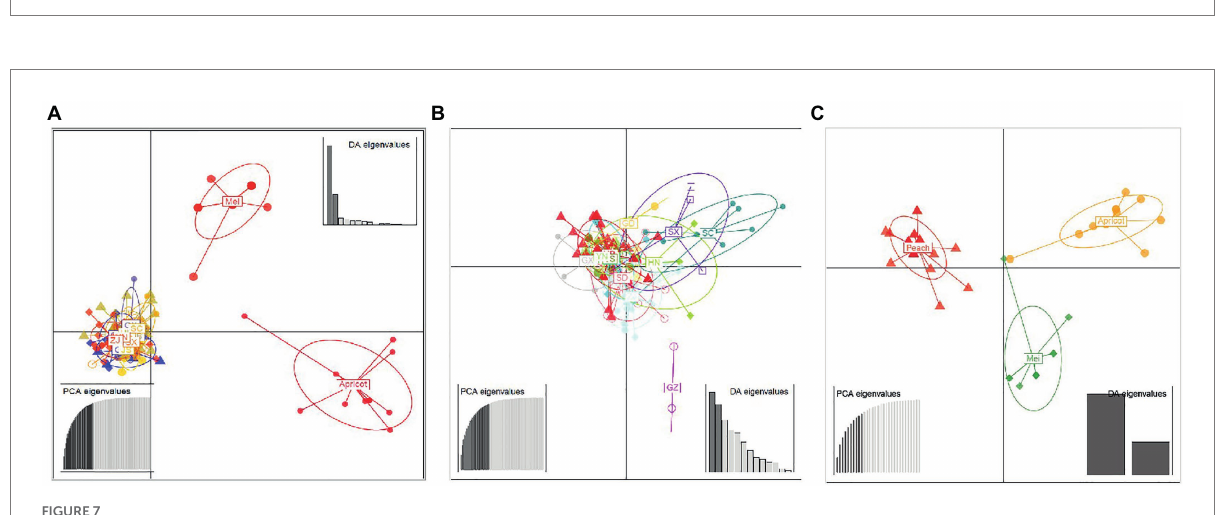
FIGURE 7 Discriminant analysis of principal components (DAPC) of Venturia carpophila populations including different geographic and host populations (A) . Discriminant analysis of principal components of 14 geographic V. carpophila populations on peach (B) . Discriminant analysis of principal components of 3 host populations (Peach, mume and apricot) V. carpophila (C) . Eigenvalues signifying the variance explained by principal component analysis (PCA) and discriminant analysis (DA) indicated that the first two principal components adequately explain the genetic structure of the populations. Points represent individual isolates and ellipses represent individual populations. There is no representation of clonal individuals in this